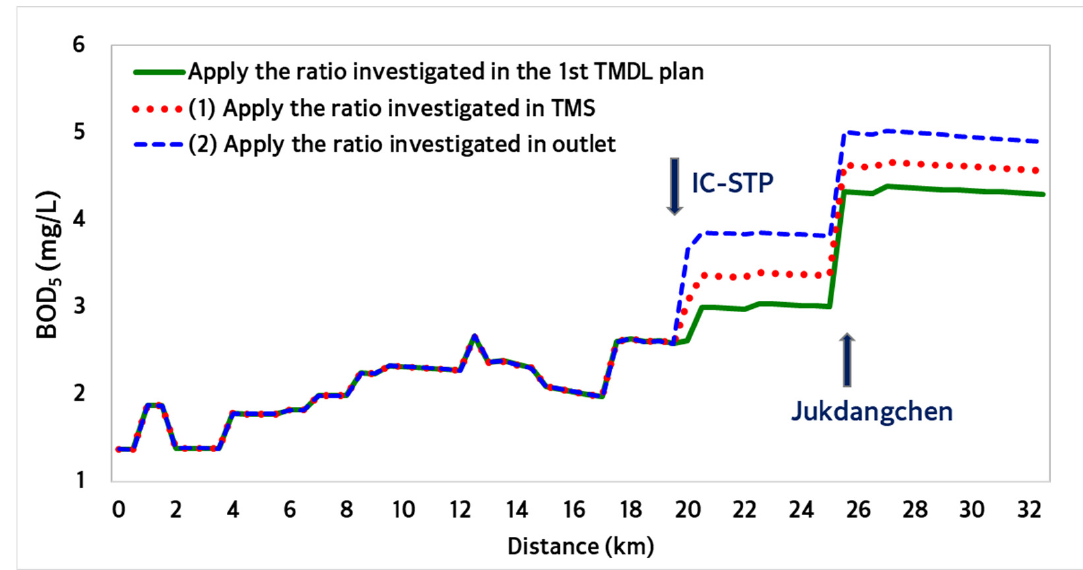
Figure 9. Effects on BOD 5 according to change in nitrogen ratio in the STP effluent.